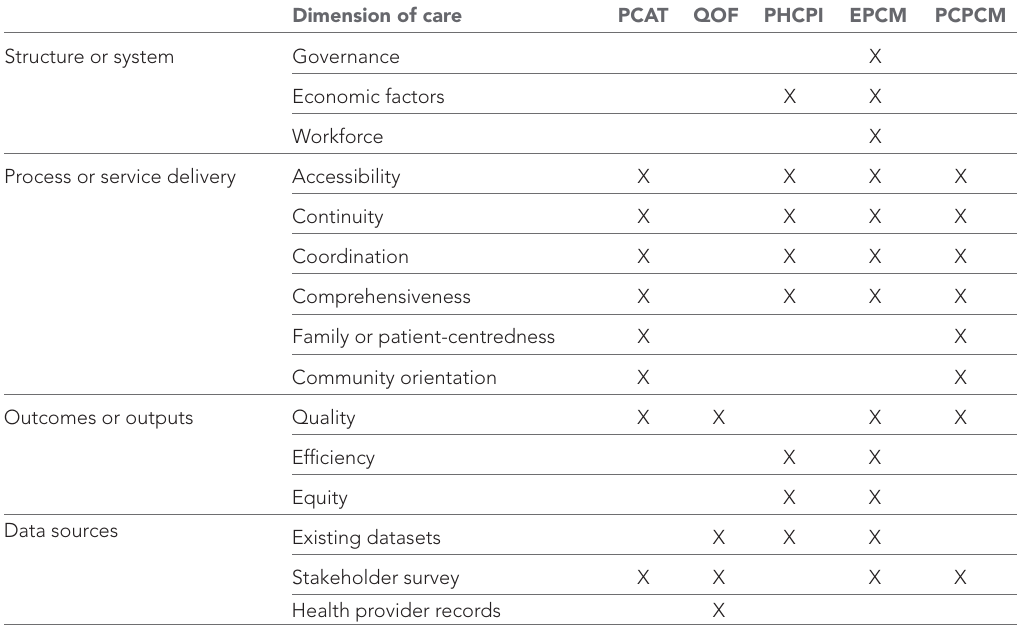
Table 1 Dimensions and data sources of tools used for measuring the strength of primary